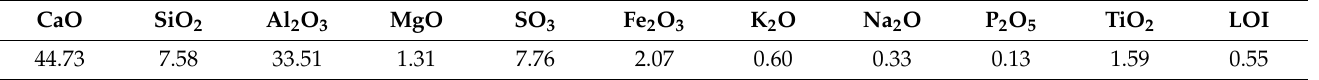
Table 1. Chemical composition (oxides in wt.%) of CSA